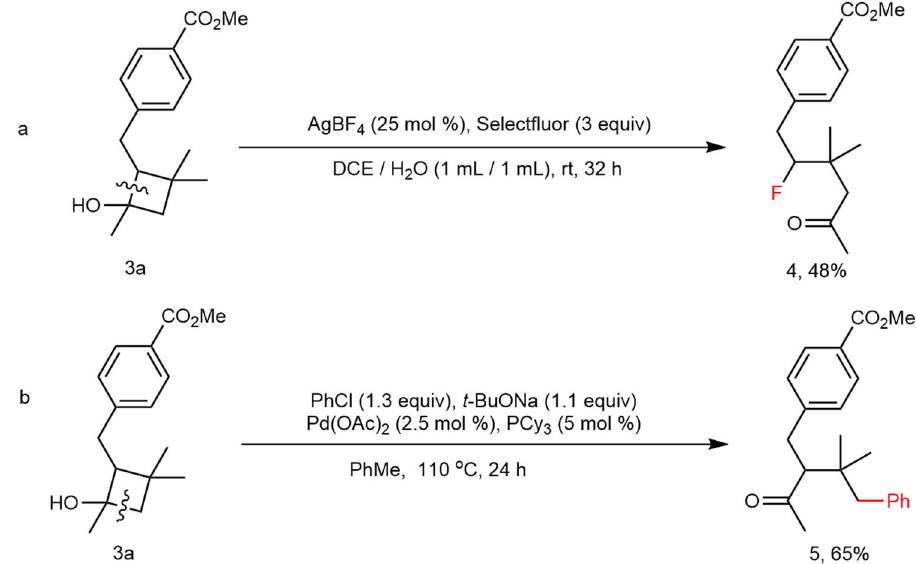
Fig. 6 Transformations of cyclobutanols. a Synthesis of γ - fl uoroketone 4 . b Synthesis of γ -arylketone 5